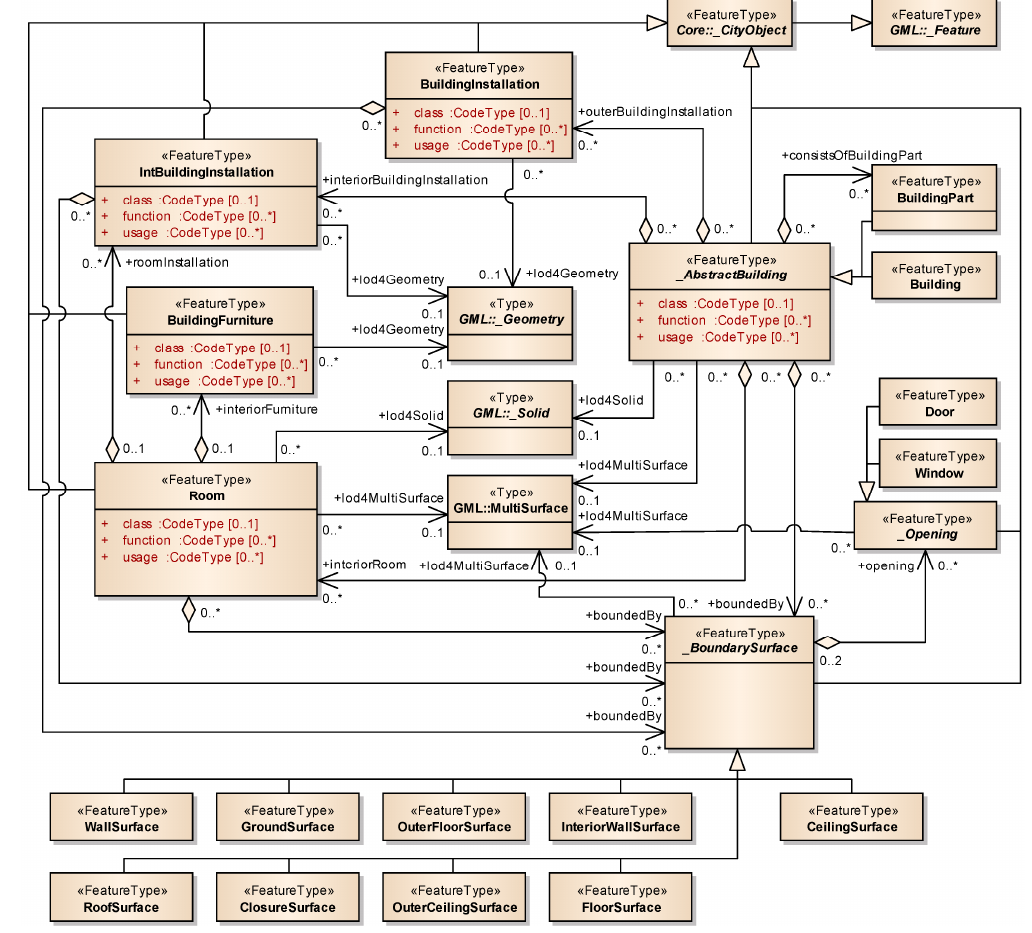
Figure 2. Building model of CityGML, adapted from [31] (p. 57).